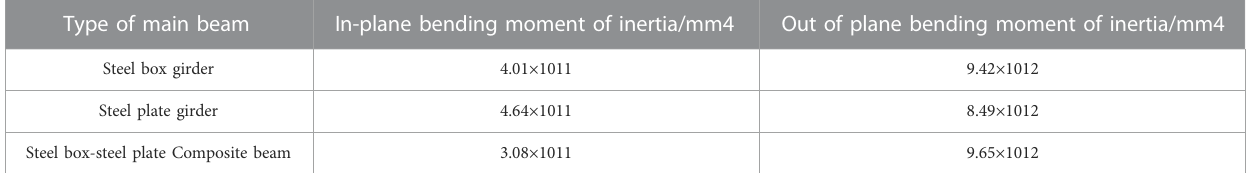
TABLE 3 Comparison of section bending